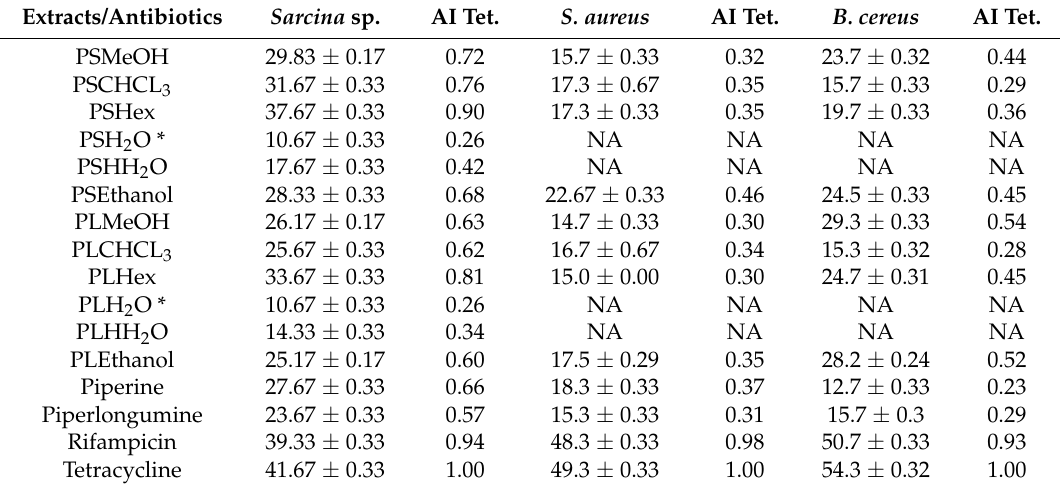
Table 2. Antibacterial effects of extracts of Piper guineense , piperine and piperlongumine against Gram-positive bacteria. Results obtained with the agar diffusion method. Activity index (AI) describes the activity of the extracts and compounds in relation to tetracycline. Extracts/Antibiotics Sarcina